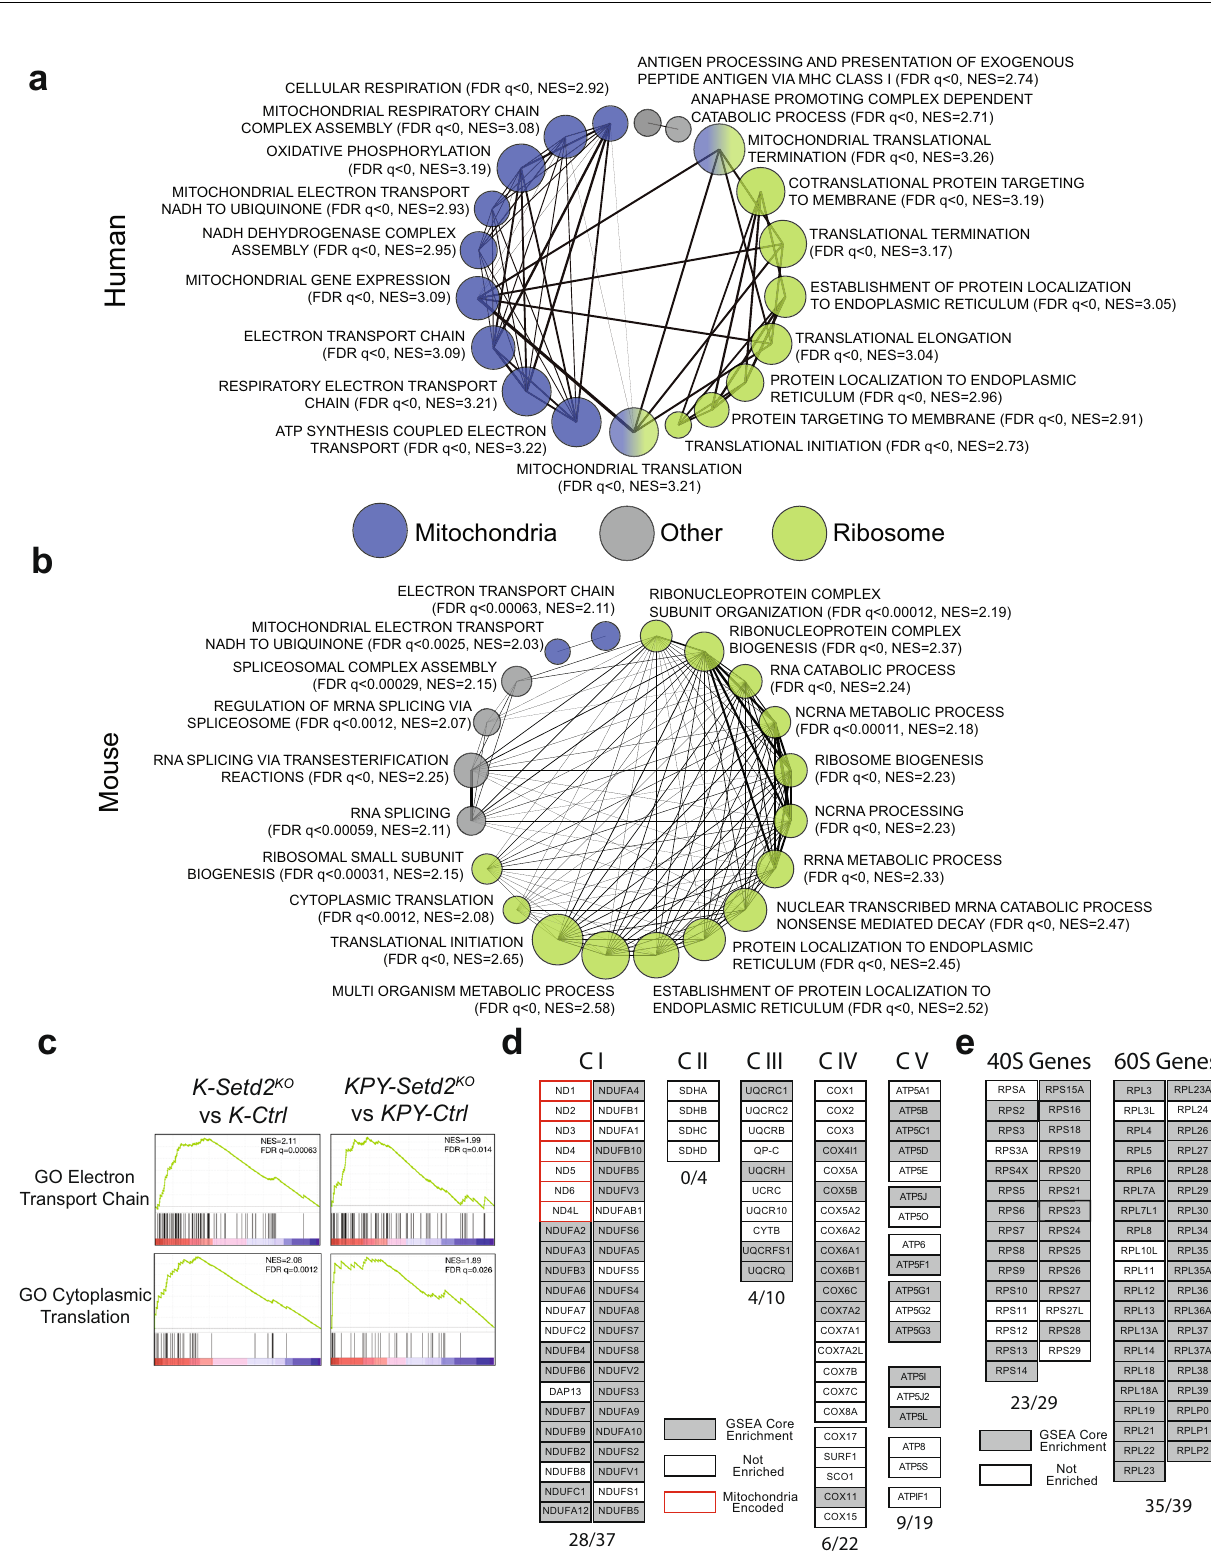
E) 23 . To assess the impact of SETD2 de fi ciency on protein synthesis, we pulse-labeled K-Ctrl and K-Setd2 KO mice with the tRNA mimetic O-propargyl-puromycin (OP-Puro). OP-Puro is incorporated into actively translated proteins to allow for quan- ti fi cation of protein synthesis by fl ow cytometry or fl uorescent microscopy and offers a method to quantify the rate of protein synthesis that is compatible with small sample sizes 24 – 26